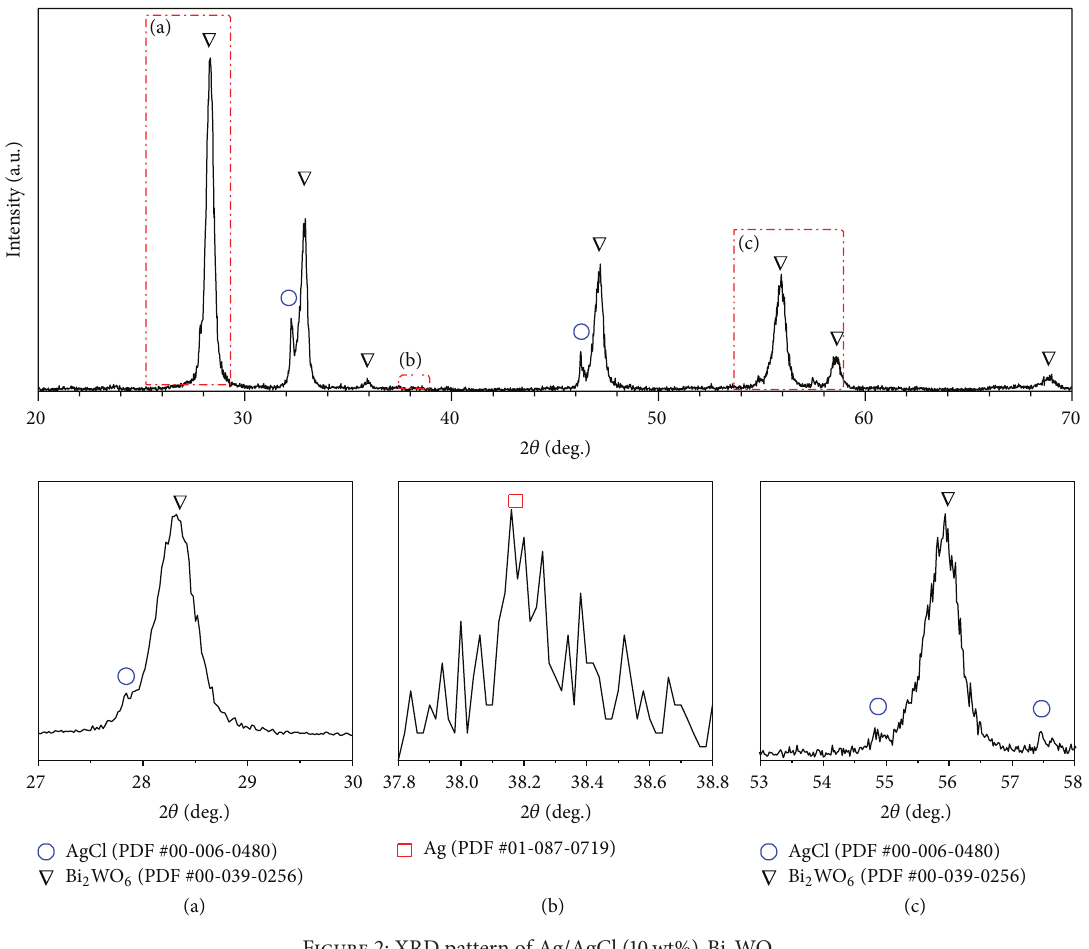
Figure 2: XRD pattern of Ag/AgCl (10wt%)-Bi 2 WO 6